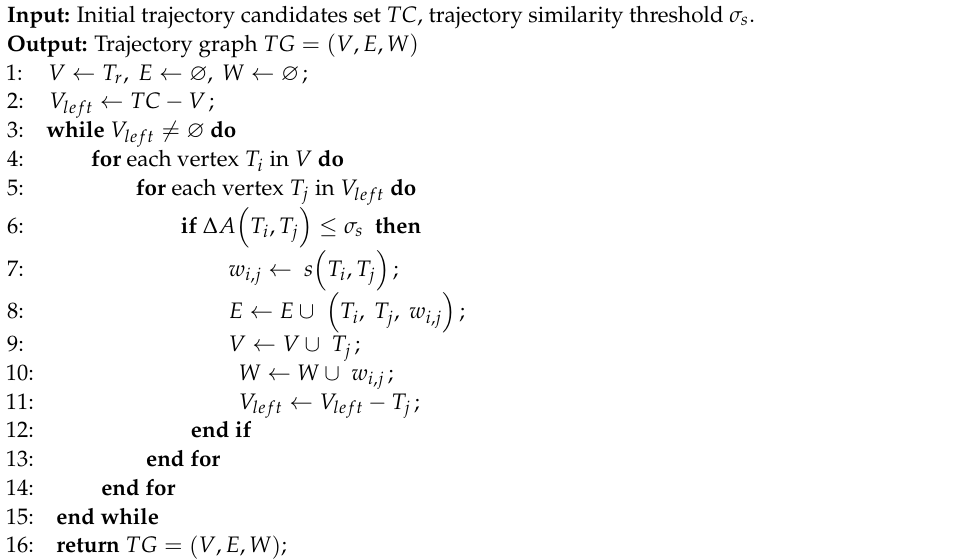
Algorithm 1. Trajectory Graph Construction (TGC)